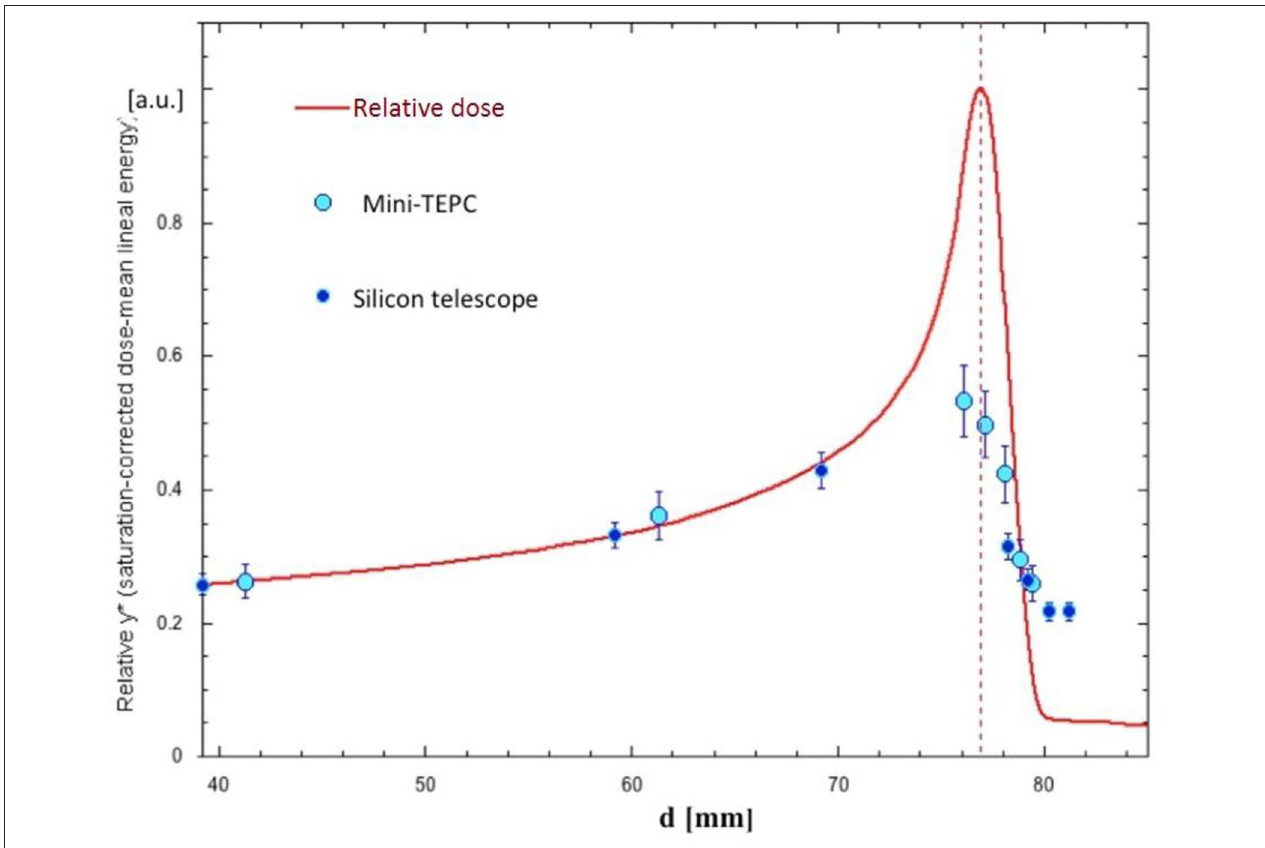
FIGURE 12 | y * (saturation-corrected dose mean lineal energy with saturation value of y 0 = 124 keV/ µ m, see text) measured with the mini-tissue-equivalent proportional counter (TEPC) and the silicon telescope detector at the Italian National Center for Oncological Hadrontherapy (CNAO). The active beam of 189.5 MeV/u